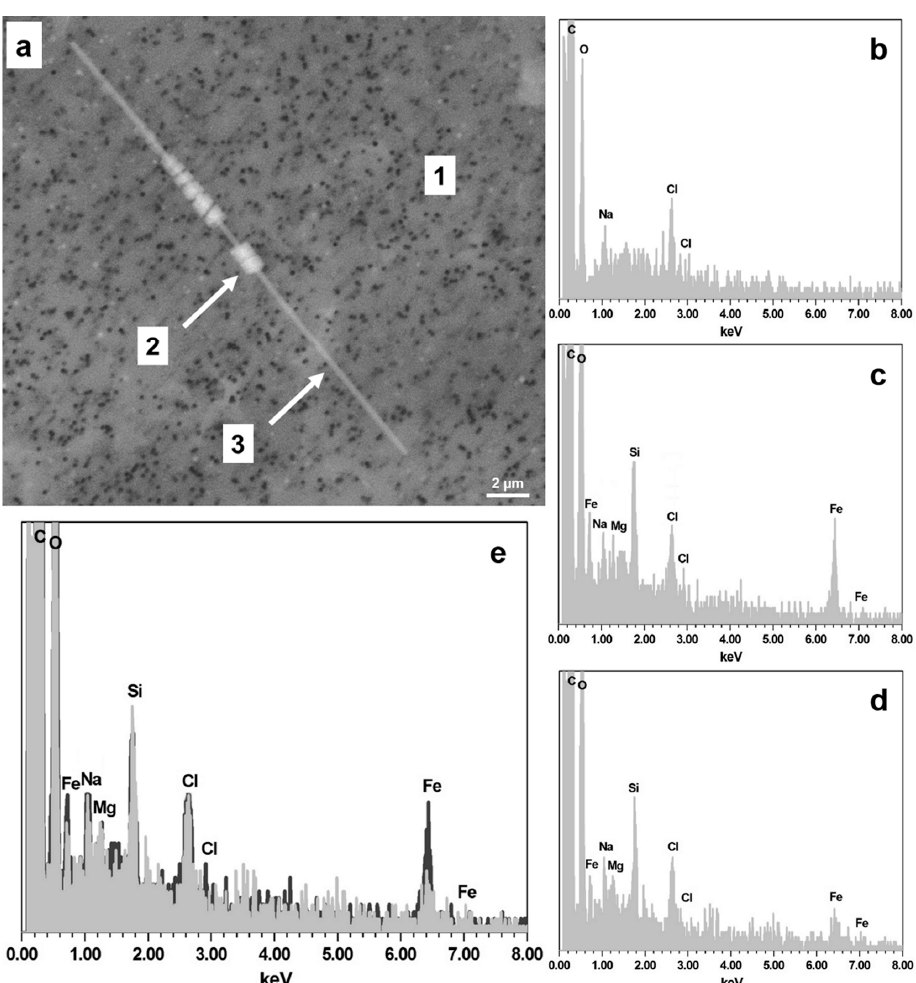
Figure 1. Asbestos body observed in digested healthy tissue and EDS analyses. ( a ) Asbestos body observed in the healthy tissue. ( b ) EDS spectrum recorded in the region labeled “1” on ( a ), far from the asbestos body. Na and Cl are the only detected ions, due to NaCl crystallization during the digestion process. ( c ) EDS spectrum recorded in the region labeled “2” on ( a ), corresponding to the covered part of the fiber. ( d ) EDS spectrum recorded in the region labeled “3” on ( a ), representing the part of the fiber free from the covering. ( e ) Superimposition of the EDS spectra in ( c , d ), showing that the fiber is composed of Si, Fe and Mg, with relative intensities leading to the identification of amosite.